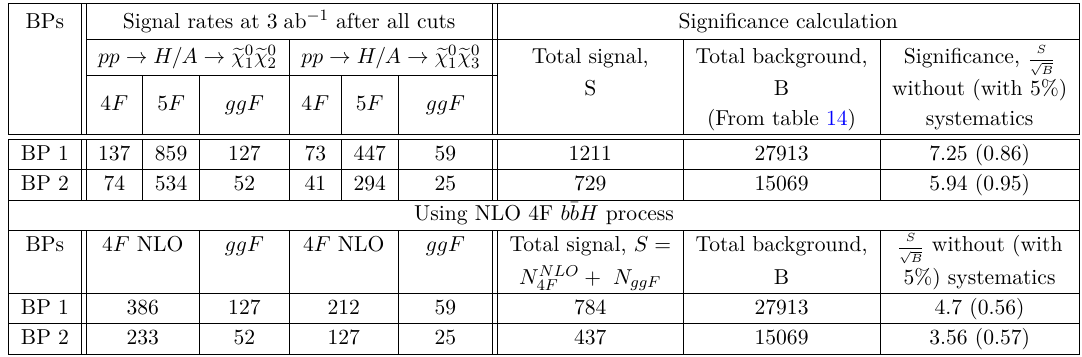
Table 15. The signal yield for two benchmark points along with signal significance for the b ¯ b + /E final state.